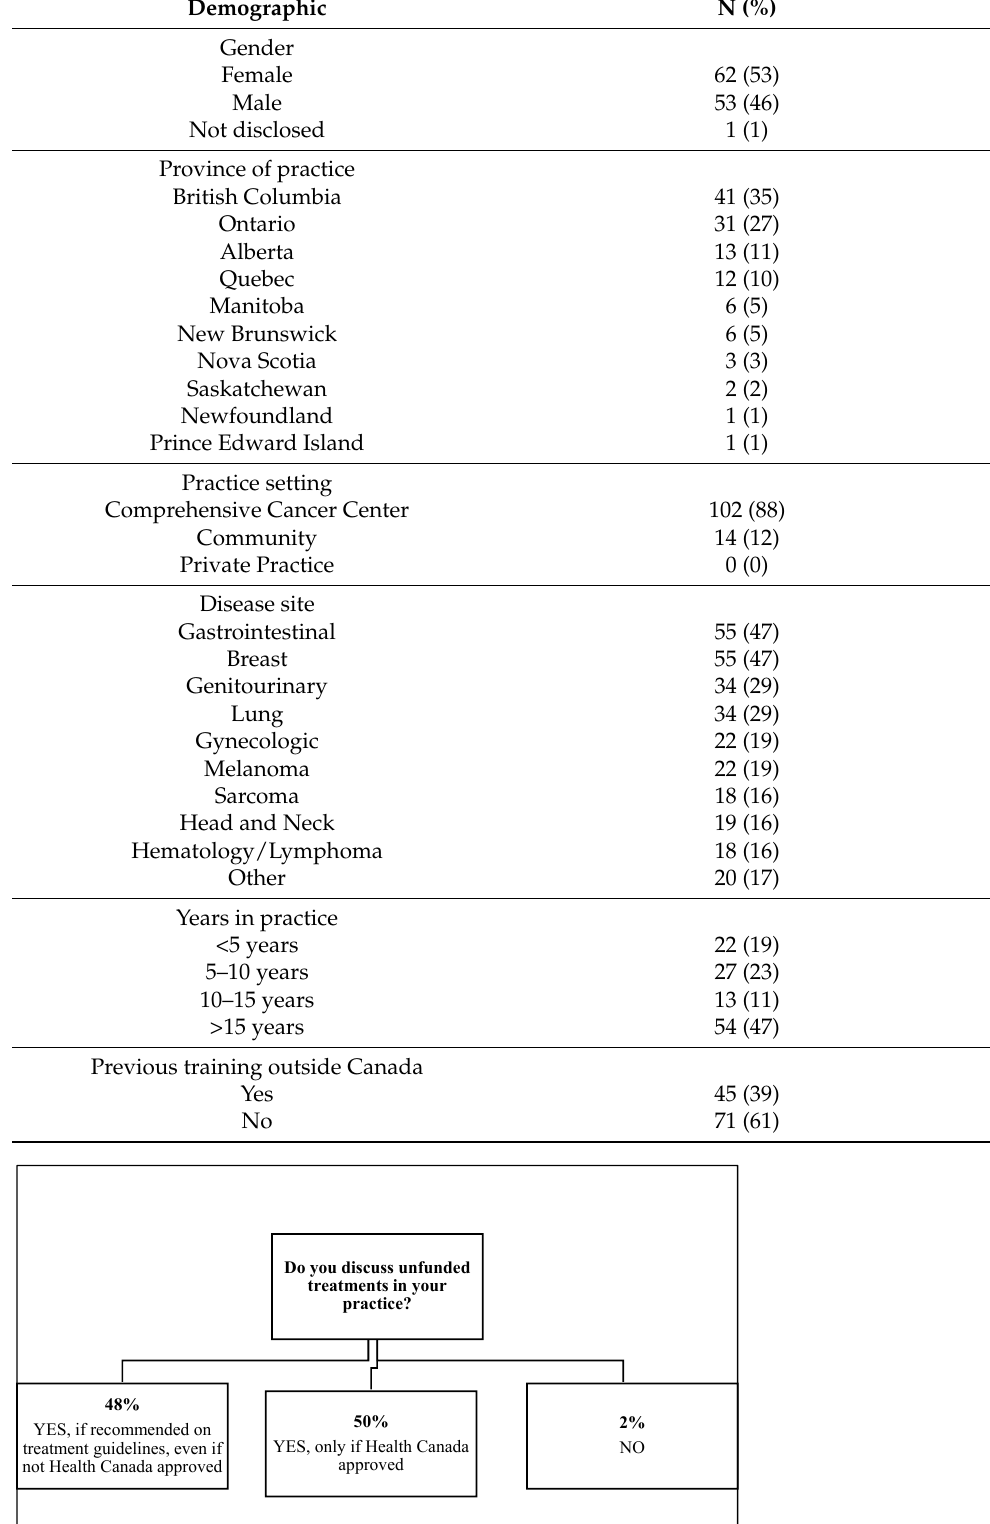
Table 1. Respondent demographics.